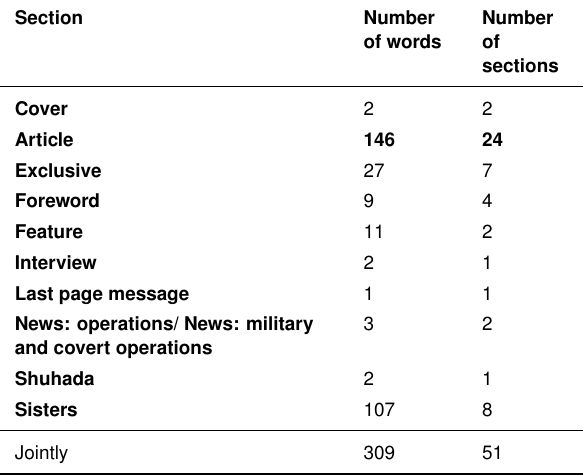
Table 4. The number of keywords and sections used in the Rumiyah